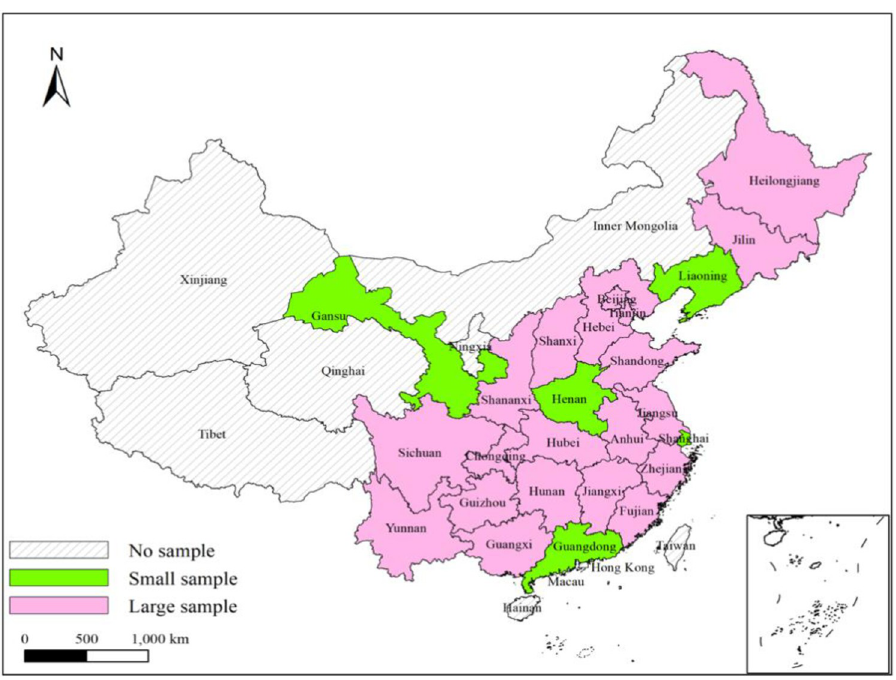
Fig 2. The sources of CFPS samples at the provincial level. Source: CFPS database